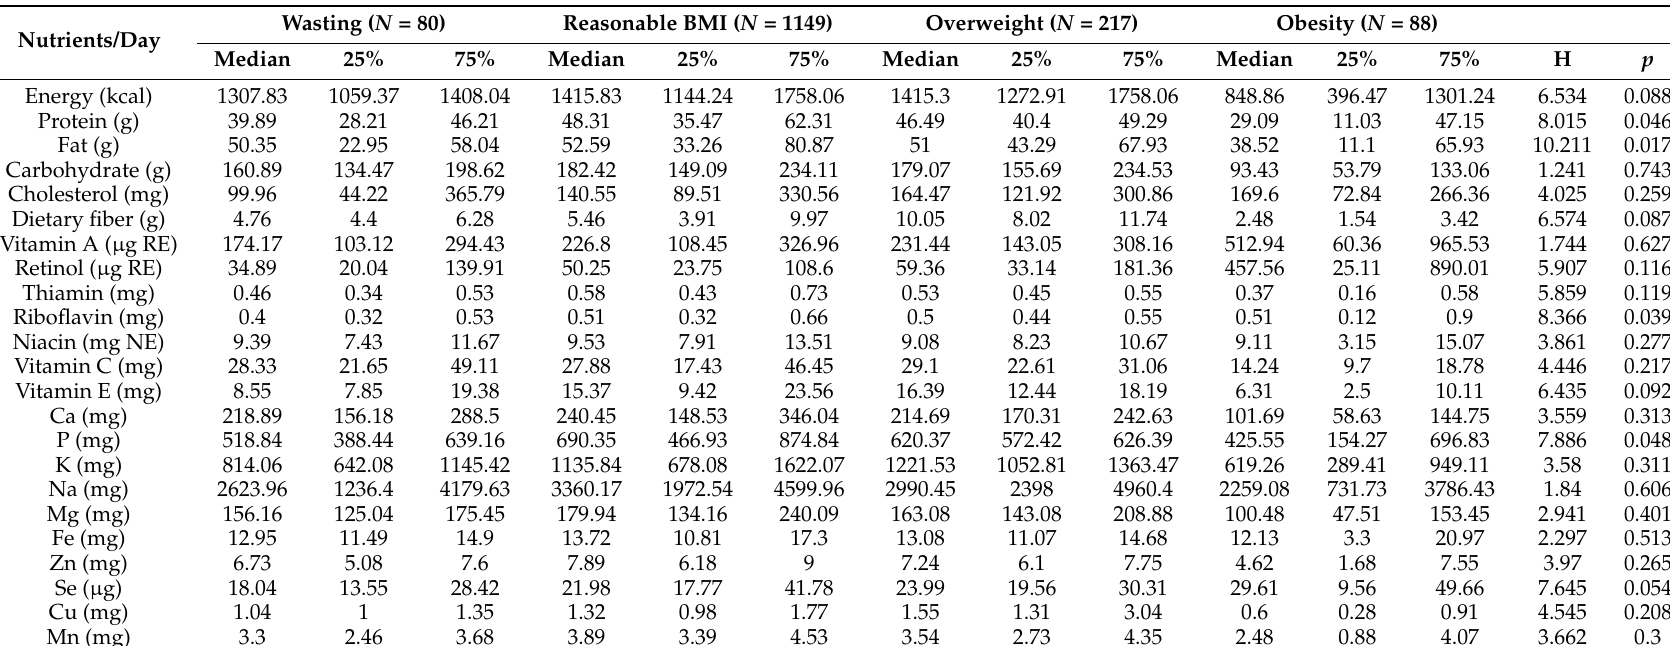
Table 5. Daily nutrient intake among children and adolescents with wasting, reasonable BMI, overweight and obesity in Zhejiang